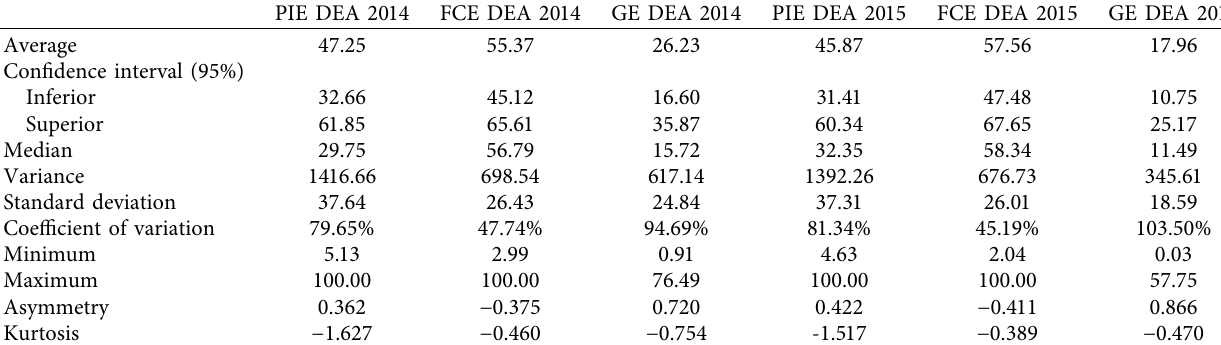
Table 3: Descriptive statistics by year and dataset Government.